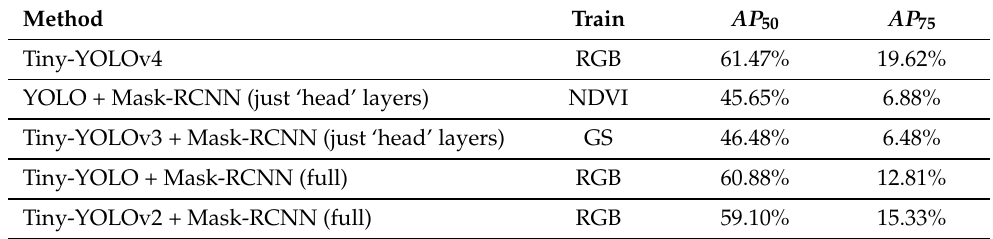
Table 6. The best results in each AP from each round of training and testing (Tables 3–5).